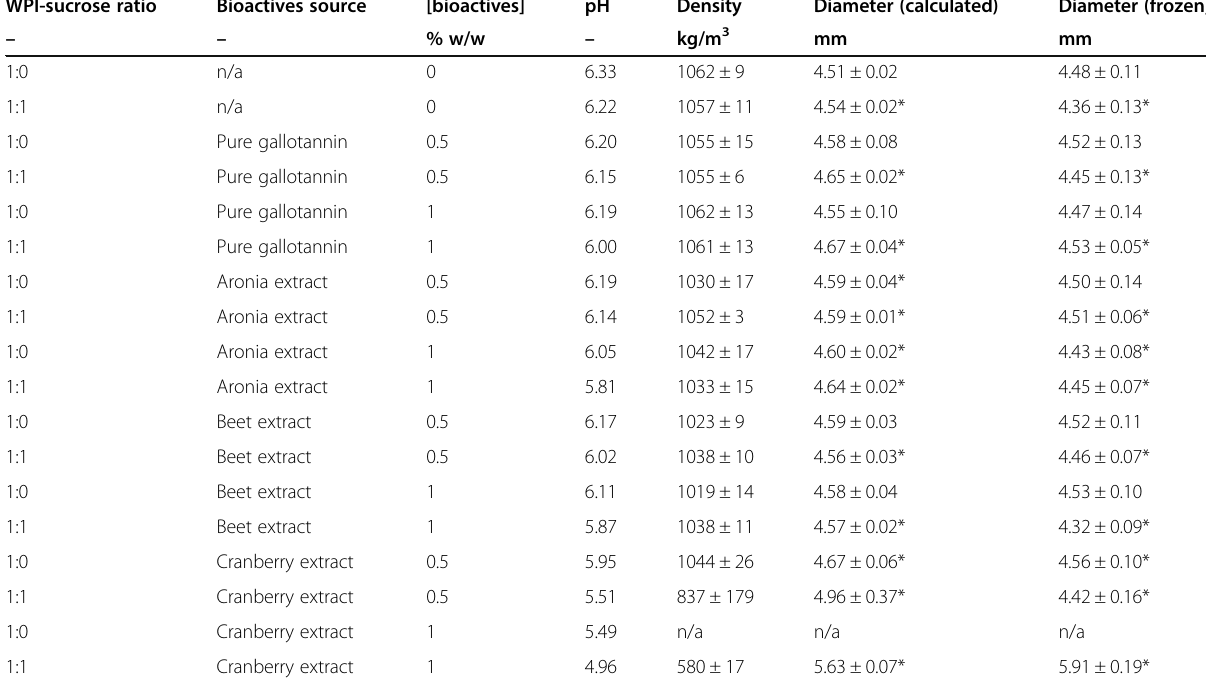
Table 1 Density and estimated drop diameters from flow tests data and measured diameters (mm) of frozen drops formed from feed dispersions with varied WPI:sucrose, bioactives sources and concentrations, and pH WPI-sucrose